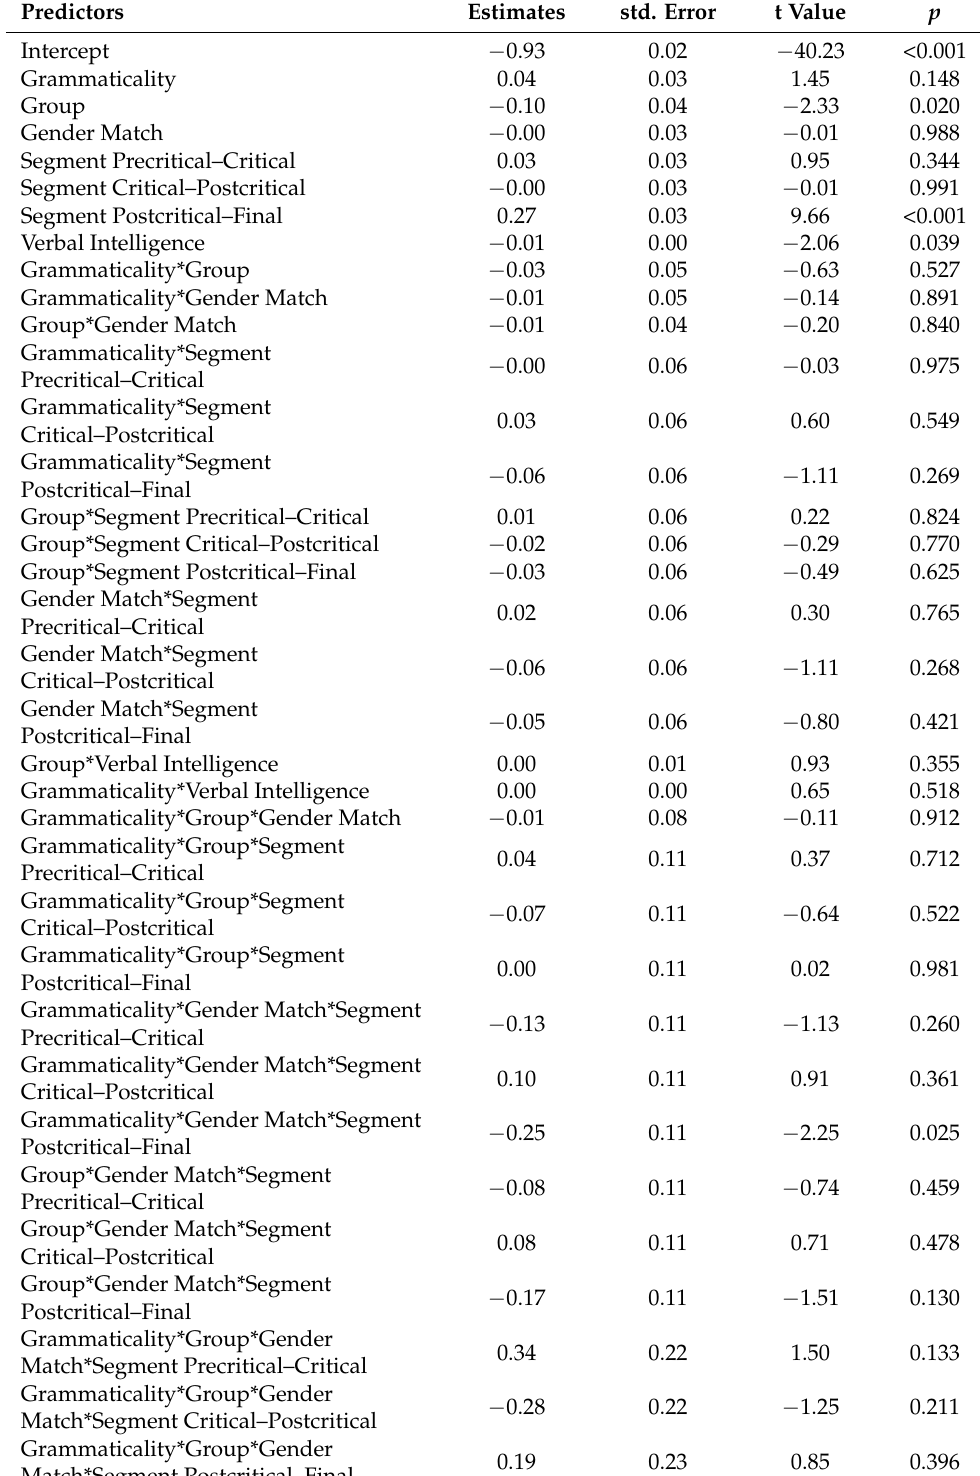
Table A11. Summary of the model for the reaction times and the effect of verbal intelligence in the comprehension